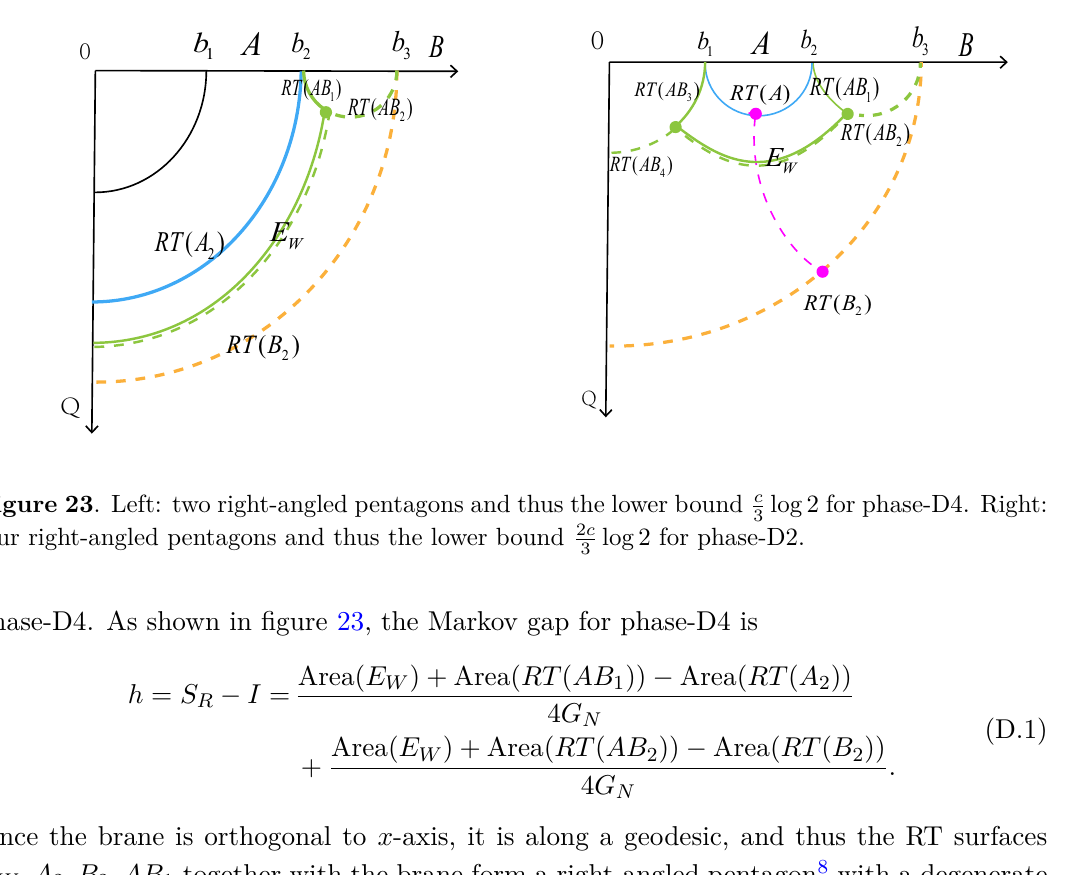
Figure 22 . A and B are gapped by two small intervals. The green line and red line denote RT surfaces for A and B , respectively. The black dashed line denotes the entanglement wedge cross- section E W between A and B . The cutoff is y UV = (cid:15) , which requires a gap of length 2 (cid:15) .